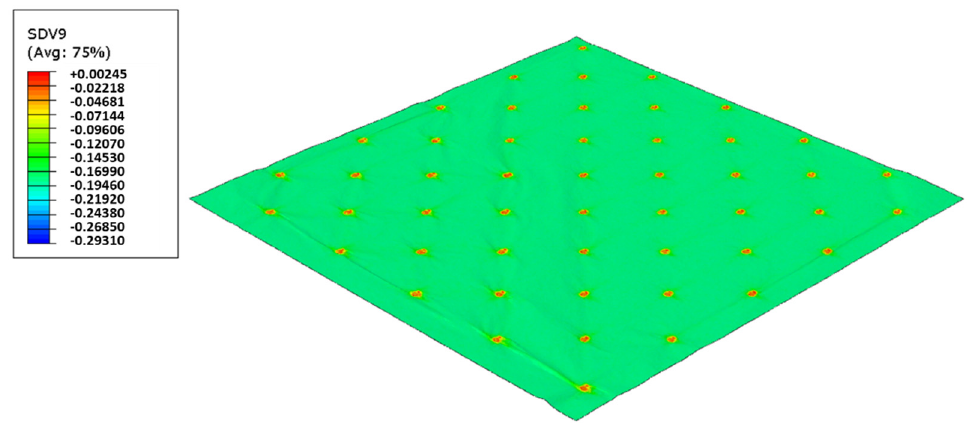
Figure 26. Micro die 60_48 Sh-A (SBR PR/NR BG), Plastic field.